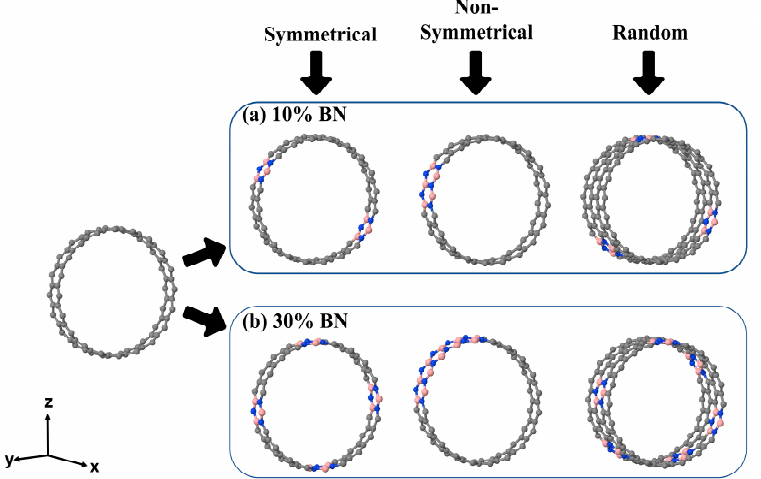
Figure 2. Unit cell of the single-wall zigazag (20,0) carbon nanotubes. The pristine model in the left panel (80 atoms) and the corresponding BN-doped structures, (BN) 1 − x C x , are shown in the upper right, x = 0.10, and lower, x = 0.30, panels, respectively, for the three different patterns. As for the double-wall, in the case of the random pattern, to preserve periodicity along x the cell must be double. Color of the atoms: gray-carbon, blue-nitrogen and